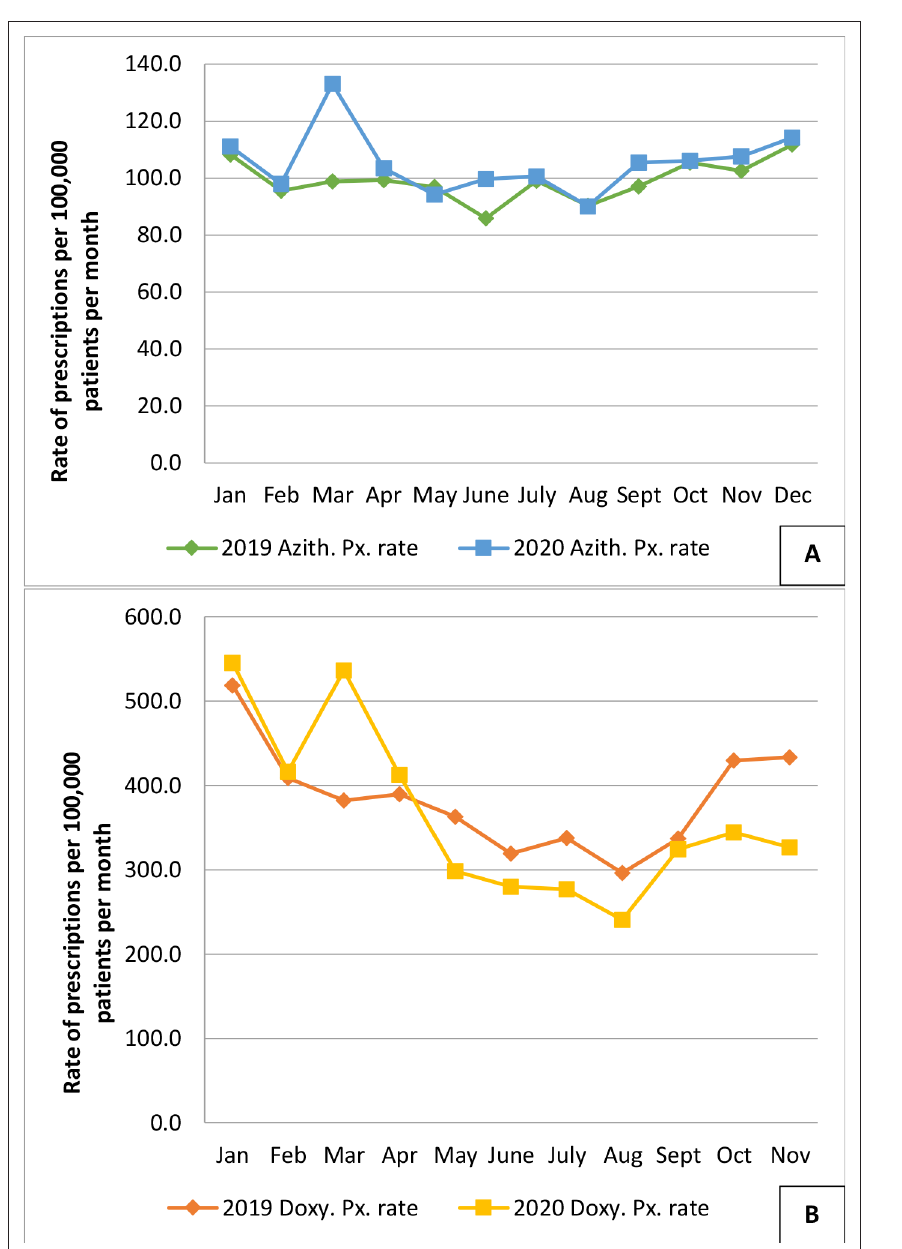
Figure 1 Prescribing of azithromycin (Figure 1A) and doxycycline (Figure 1B) by month within the Research and Surveillance Centre. The 2020 prescription of both antibiotics (azithromycin = blue line, square markers; doxycycline = yellow line, square markers) was very similar in January and February to 2019 rates (azithromycin = green line, diamond markers; doxycycline = orange line; diamond markers). In March 2020, there was a peak of prescribing for both antibiotcs, coincident with the first wave of the COVID-19 pandemic. Thereafter azithromycin was prescribed in 2020 at or above the level in 2019, whereas doxycycline was prescribed less. Azith = azithromycin. Doxy = doxycycline. Px =